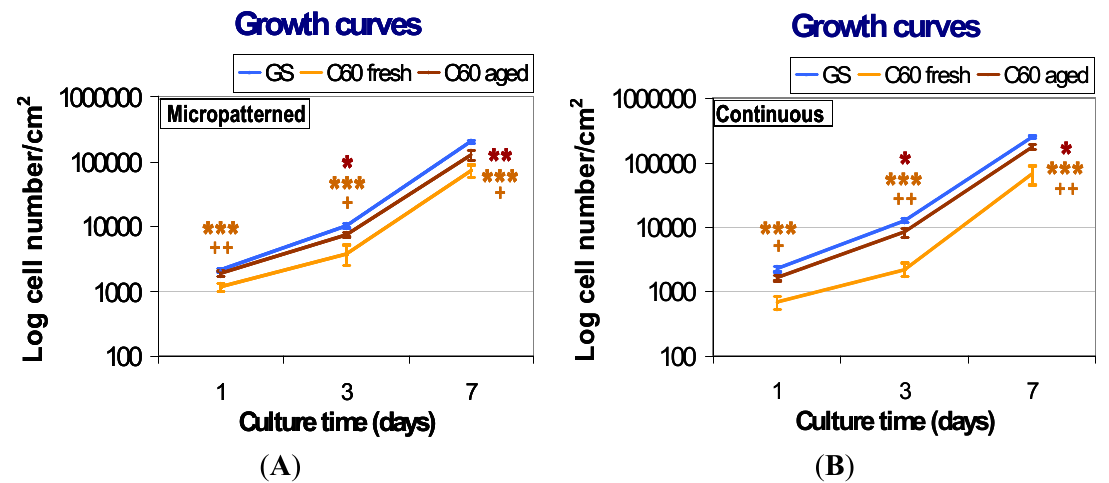
Figure 8. Growth curves of human osteoblast-like MG-63 cells on micropatterned ( A ) or continuous ( B ) fresh and aged fullerene films. GS, microscopic glass coverslips, reference material; * significant difference to GS; + significant difference to C ( *** /+++); p ≤ 0.01 ( ** /++); p ≤ 0.05 ( *